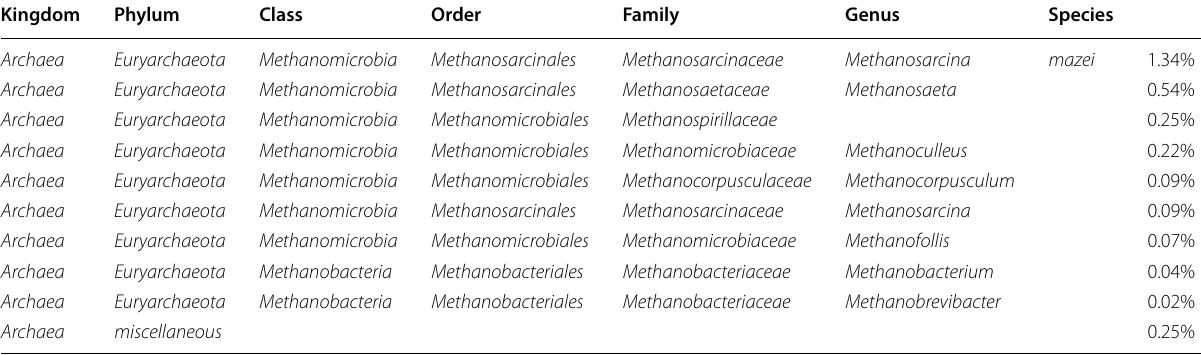
Table 3 Identification of methanogens by 16S rRNA